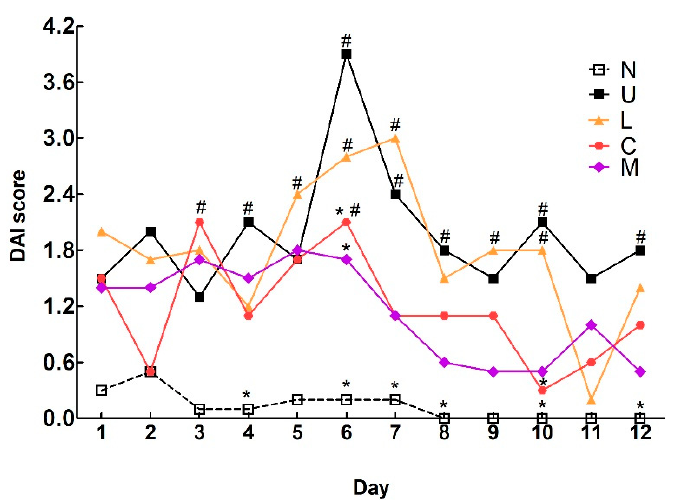
Figure 1. Effects of Lycium barbarum polysaccharides (LBP) and capsaicin (CAP) on disease activity index (DAI) scores in dextran sulfate sodium-induced colitis rats. N: control group, U: ulcerative colitis induced group, L: LBP treated group, C: CAP treated group, M: mixed LBP and CAP